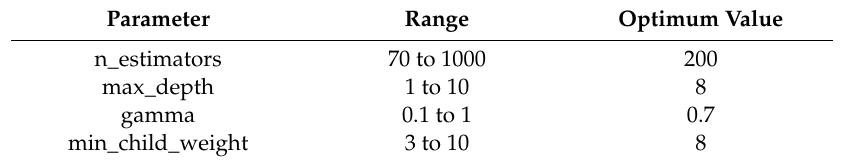
Table 3. Extreme Gradient Boosting regression modeling hyperparameters from the grid